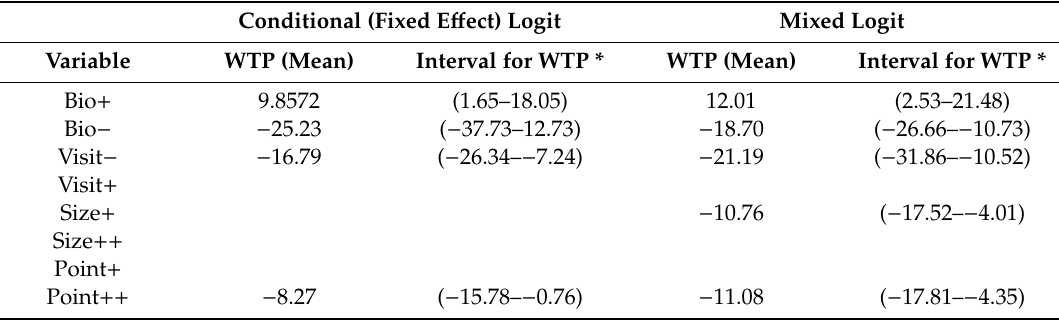
Table 5. Estimates of willingness to pay for attributes.